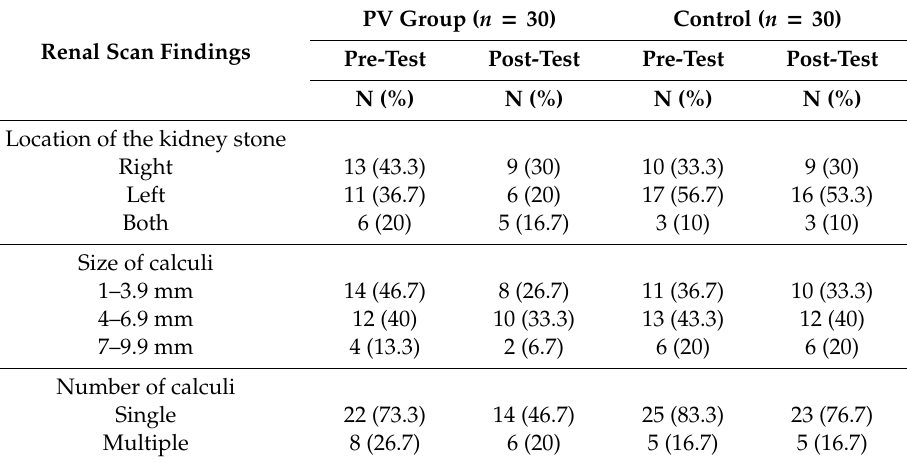
Table 5. Urinary